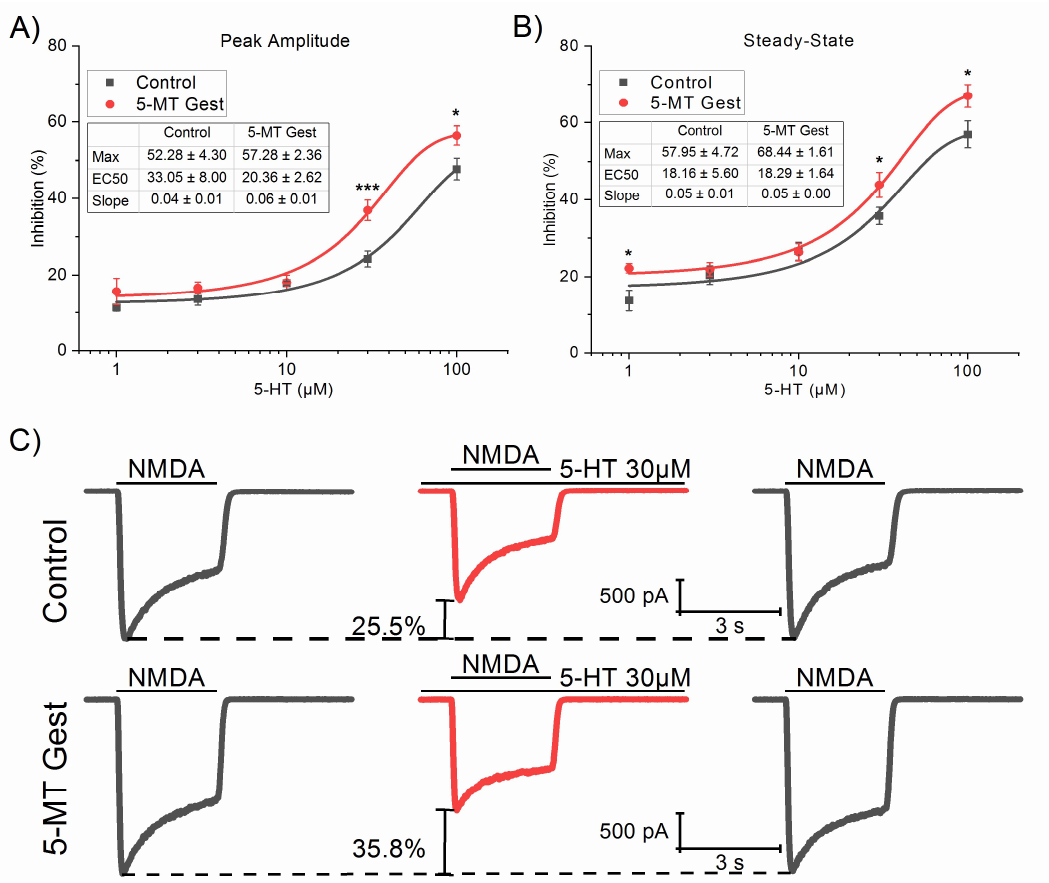
Figure 6: Dose-response curve for the effect of 5-HT from 1 to 100 µM in the I NMDA (100 µM). As with the NMDA dose-response, data were analyzed, fitted (solid lines), and compared with an F-test. In this way, we found significant differences between groups in both the peak amplitude ( A ; F 3,125 = 10.36, p < 0.001) and the steady-state ( B , F 3,125 = 4.23, p = 0.007). Also, the difference between groups for each concentration was measured, finding significance in 30 µM (t25.57 = −4.42, p < 0.001) and 100 µM (t23.01 = −2.33, p = 0.03) for peak amplitude, and 1 µM (t15.48 = −2.88, p = 0.01), 30 µM (t26.74 = −2.07, p = 0.048), and 100 µM (t22.14 = −2.18, p = 0.04) for SS. ( C ) Representative traces of I NMDA in the presence and absence of 5-HT 30 µM. Significance codes: p < 0.001 (***), p < 0.01 (**), p < 0.05 (*). Table 3. Comparison between groups of the percentage inhibitión of the peak amplitude and steady-state of the I NMDA for each 5-HT concentration.